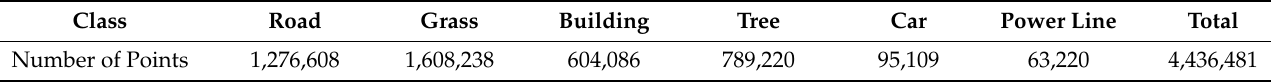
Table 2. Reference points for the six